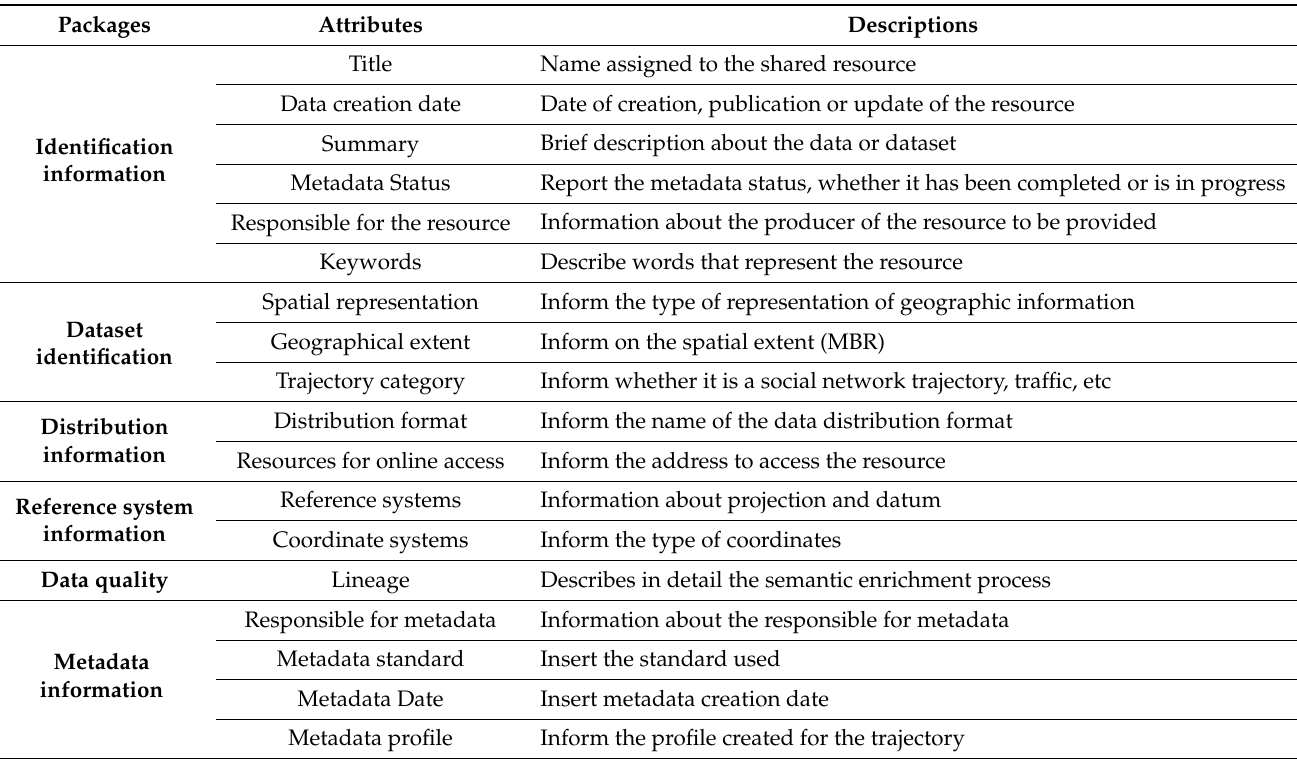
Table 1. Set of fields for STMO